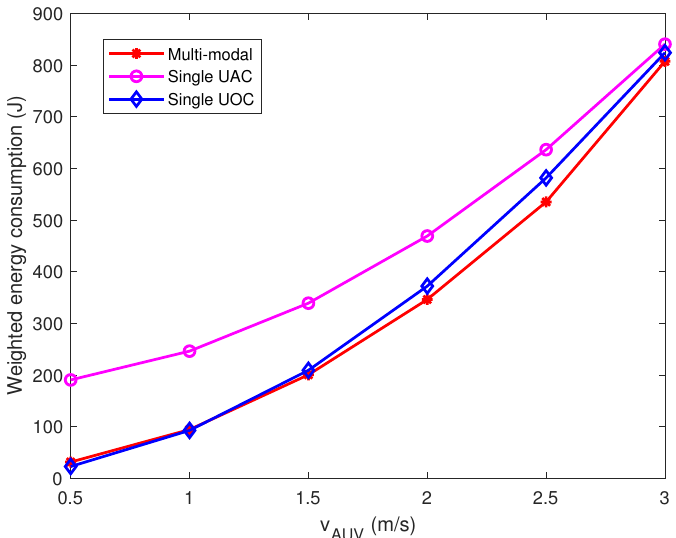
Figure 5. Effect of AUV velocity on the weighted energy consumption of the